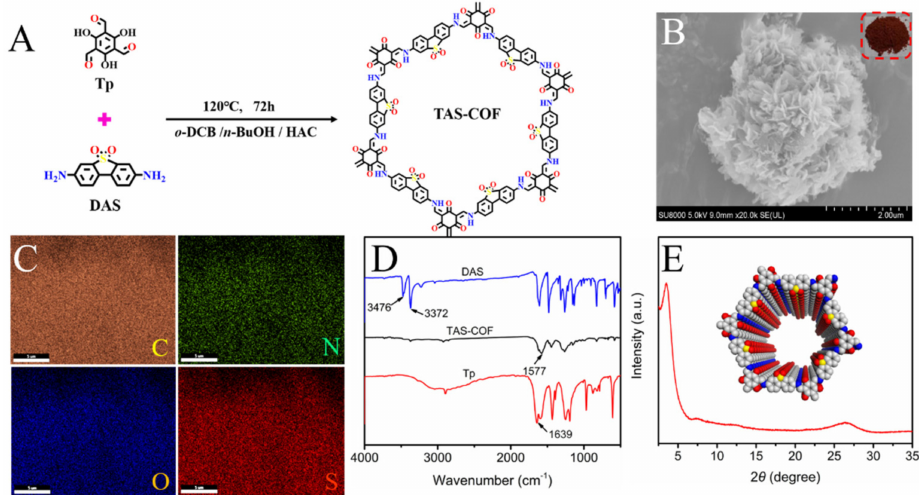
Figure 1. ( A ) Schematic representation for the preparation of TAS-COF. ( B ) SEM image of TAS-COF (Insert: the picture of TAS-COF). ( C ) EDS mapping of TAS-COF. ( D ) FT − IR spectra of Tp, DAS, and TAS-COF. ( E ) XRD pattern of TAS-COF (Insert: image of the space − filling diagram, gray: C, blue: N, red: O, yellow: